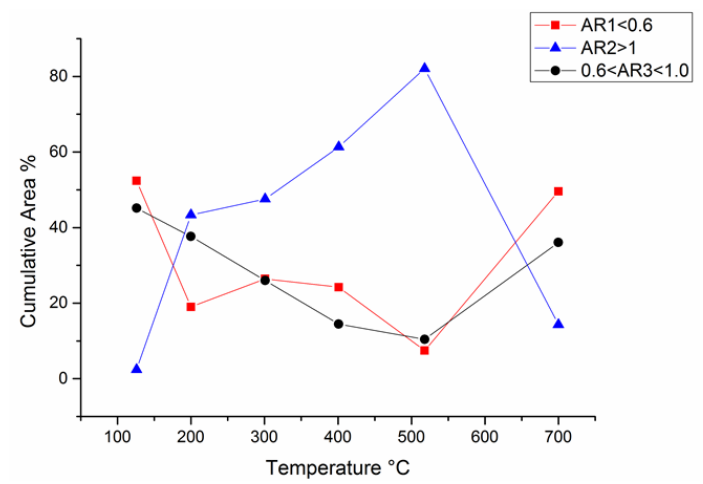
Figure 23. Cumulative area (CA) vs. quenching temperature for the three ranges of atomic ratio (AR): the values of AR1, AR2, and AR3.